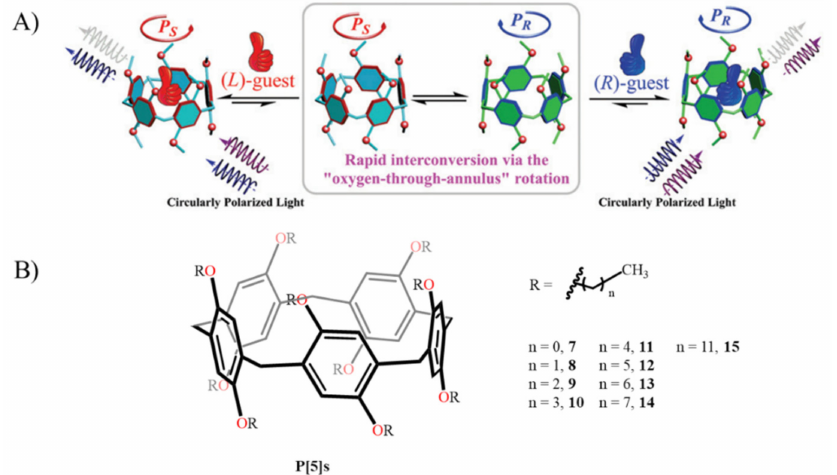
Figure 5. ( A ) Mechanism of planar chiral induction of P[5]s. Reprinted (adapted) with permission from Ref. [27] Copyright 2020 from The Royal Society of Chemistry. ( B ) Chemical structures of P[5]s with different chain